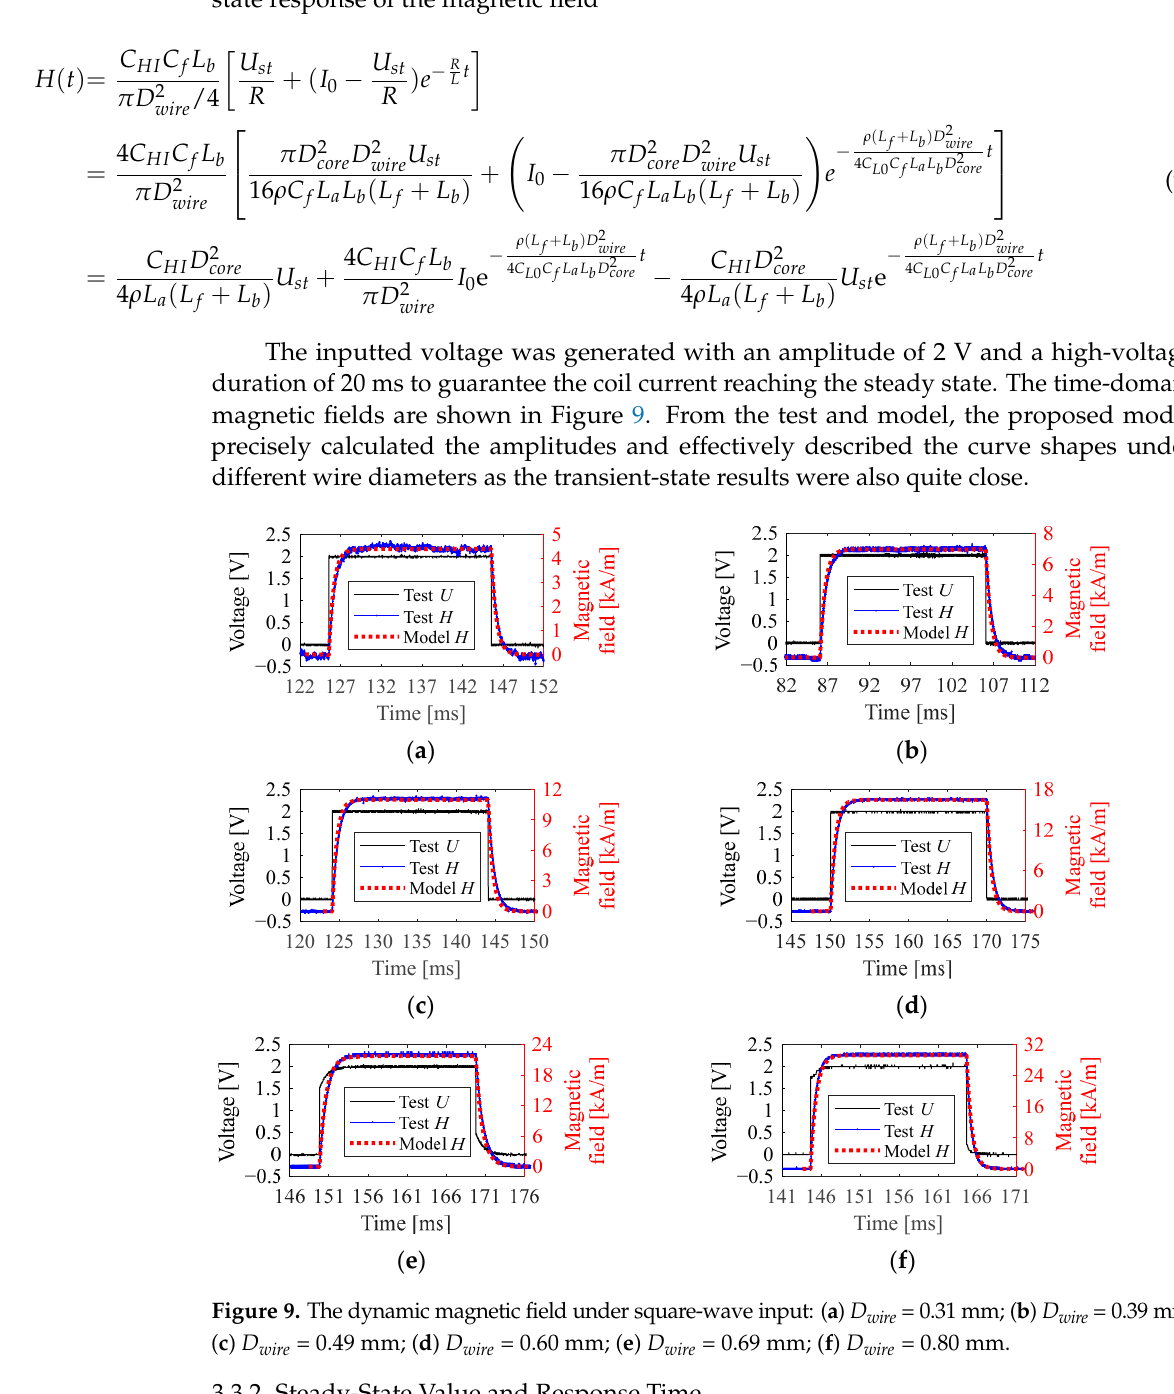
Figure 9. The dynamic magnetic field under square-wave input: ( a ) D wire = 0.31 mm; ( b ) D wire = 0.39 mm; ( c ) D wire = 0.49 mm; ( d ) D wire = 0.60 mm; ( e ) D wire = 0.69 mm; ( f ) D wire = 0.80 mm.